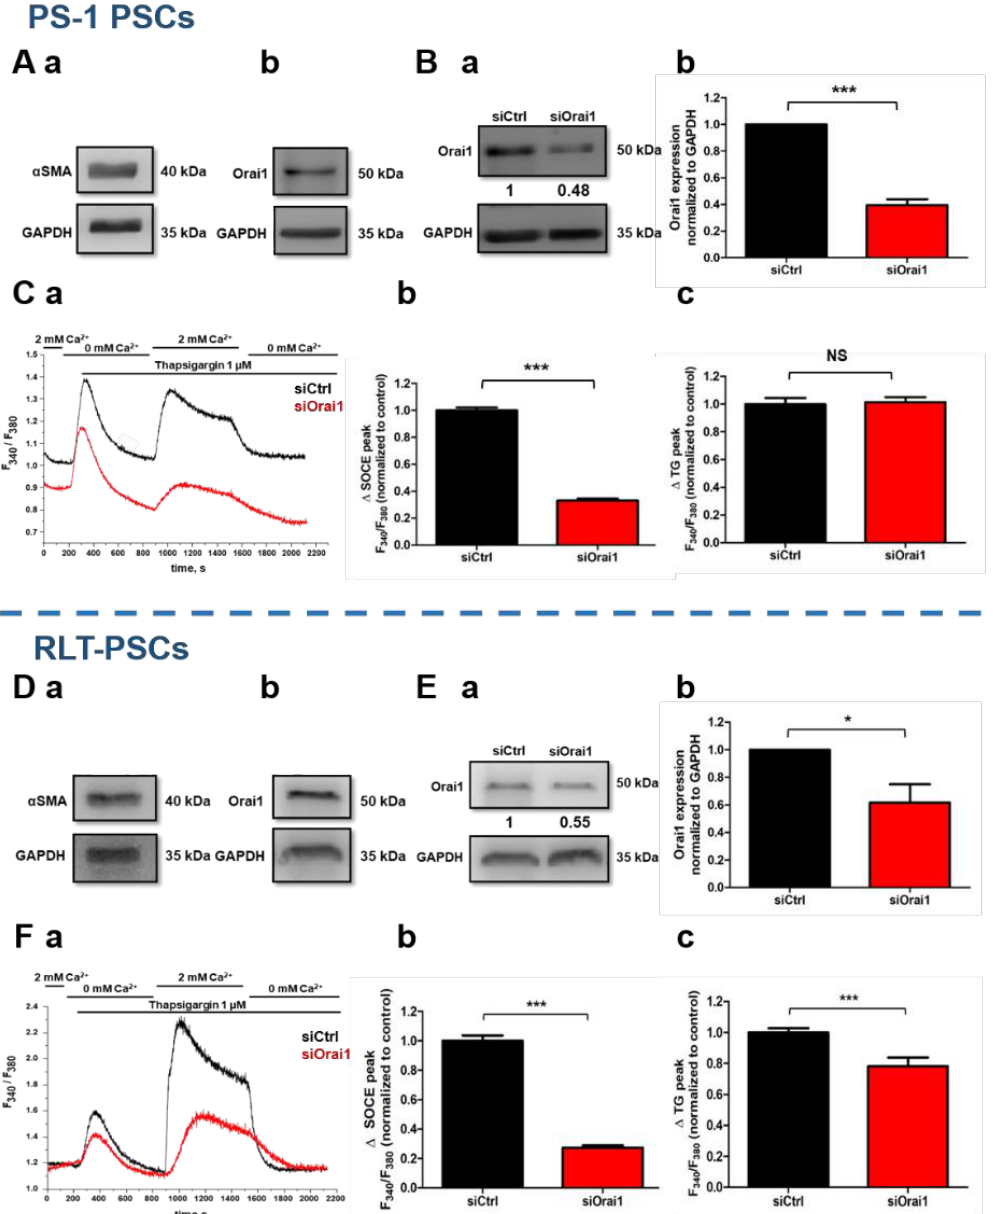
Figure 1. Orai1 channel is functionally expressed in human-activated PSCs by regulating the store-operated Ca 2+ entry (SOCE). ( A , D ) Protein expression of αSMA, the principal marker of PSC activation ( Aa , Da ), and Orai1 channel ( Ab , Db ), by Western blot, 72 h post-proliferation, in PS-1 ( A ) and RLT ( D ) human-activated PSCs. ( B , E ) Evaluation of Orai1 siRNA 72 h post-transfection efficiency by Western blot. Illustrative Western blot of Orai1 protein inhibition ( Ba , Ea ), with the quantification ( Bb , Eb ), in both PS-1 ( B ) and RTL ( E ) PSCs. Western blotting results were first normalized to the referent protein GAPDH and then to the control (N = 3, * p < 0.05, *** p < 0.001, Student’s t- test). ( C , F ) Assessment of Orai1 channel’s function in siOrai1 transfected PS-1 ( C ) and RLT ( F ) cells, using calcium imaging, 72 h post-transfection. SOCE was measured after endoplasmic reticulum release induced by 1 µ M of thapsigargin, illustrated by representative traces ( Ca , Fa ) of SOCE measurements in both cell lines. All histograms are represented as the average ± SEM normalized to the control, of SOCE (siCtrl: n = 210, siOrai1: n = 189, N = 5 for PS-1 cells, ( Cb )) (siCtrl: n = 91, siOrai1: n = 80, N = 3 for RLT cells, ( Fb )), and of endoplasmic reticulum release induced by 1 µ M Thapsigargin (siCtrl: n = 210, siOrai1: n = 184, N = 5 for PS-1 cells, ( Cc )) (siCtrl: n = 91, siOrai1: n = 80, N = 3 for RLT cells, ( Fc )) (* p < 0.001, NS: no significant, Student’s t- test, n: number of cells, N: number of